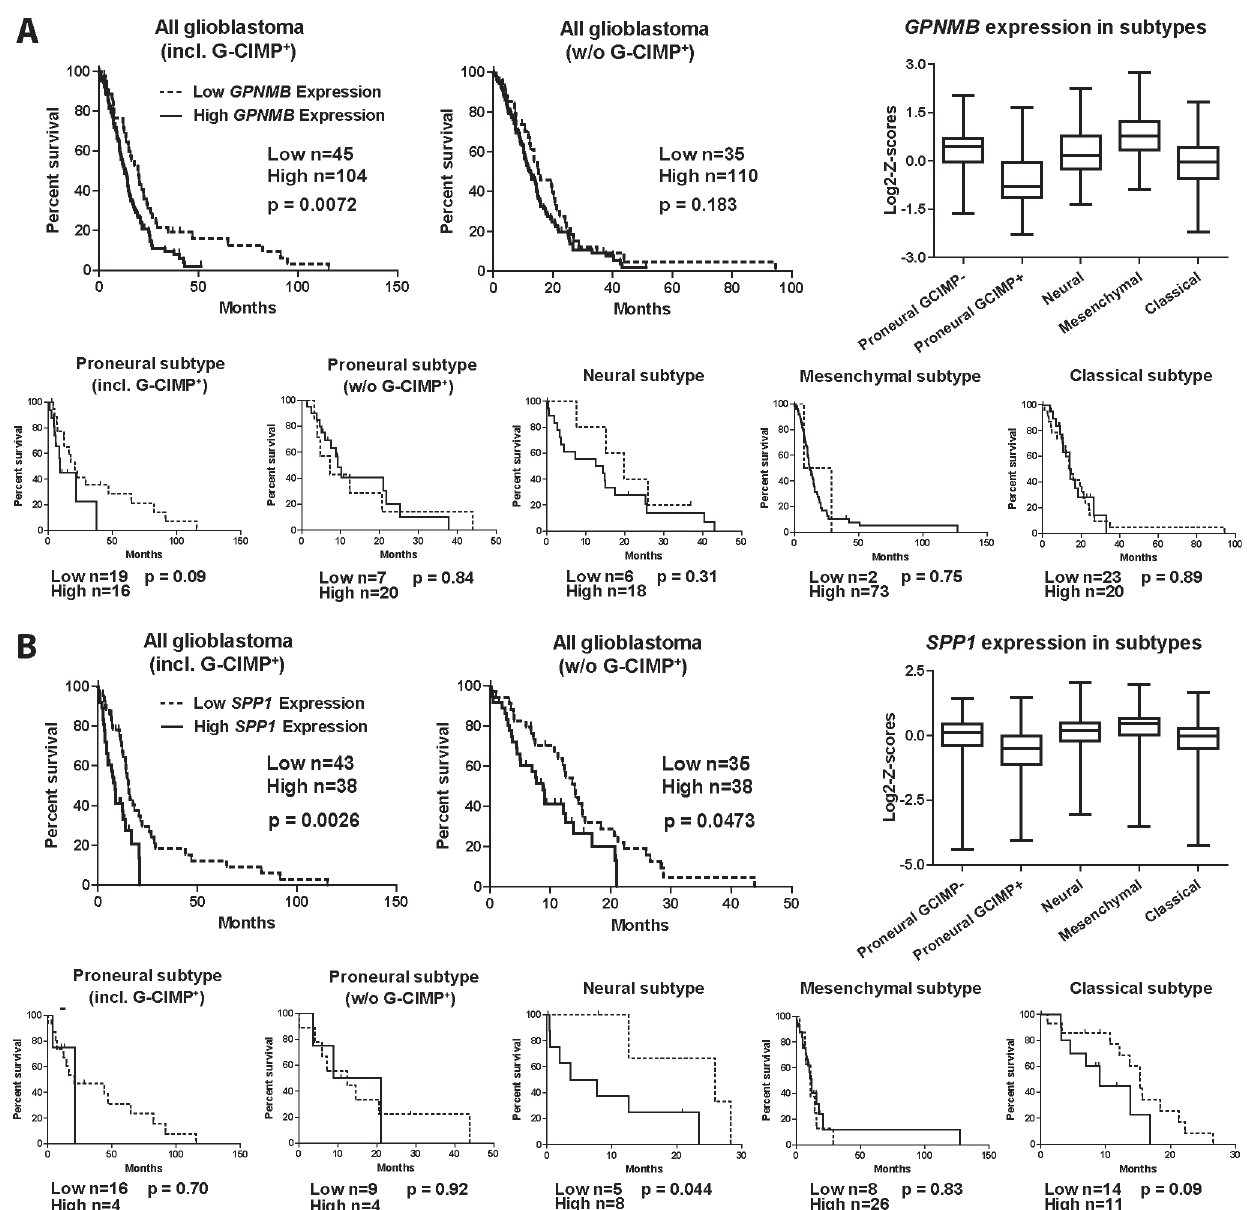
Fig 9. High GPNMB and SPP1 expression is associated with worsened survival prognosis in human GBM patients. Data taken from the TCGA database, showing survival probability of glioma patients grouped according to high and low expression of our target genes GPNMB (A) and SPP1 (B). High expression of both genes has a negative effect on patient prognosis. Patients were in addition grouped into the four molecular subtypes (proneural, neural, mesenchymal, and classical). Low GPNMB expression seems to have the most severe effect on patient prognosis in the proneural subtype when including G-CIMP + tumors, but no significant effect in the other subtypes. Low SPP1 expression seems to have the highest effect on patient prognosis in the neural and classical subtypes. Furthermore, both genes are differently regulated in the four subtypes (box plots in A and B) Significances for box plots: GPNMB : proneural GCIMP- (PG-) vs. proneural GCIMP+ (PG+) *** , PG- vs. mesenchymal (M) *** PG- vs. classical (C) ** , PG+ vs. neural (N) *** , PG+ vs. M *** , PG+ vs. C ** , N vs. M *** , N vs. C * , M vs. C *** . SPP1 : PG- vs. M *** , PG+ vs. N *** , PG+ vs. M *** , C vs. M *** . * , p < 0.05; ** , p < 0.01; *** , p <